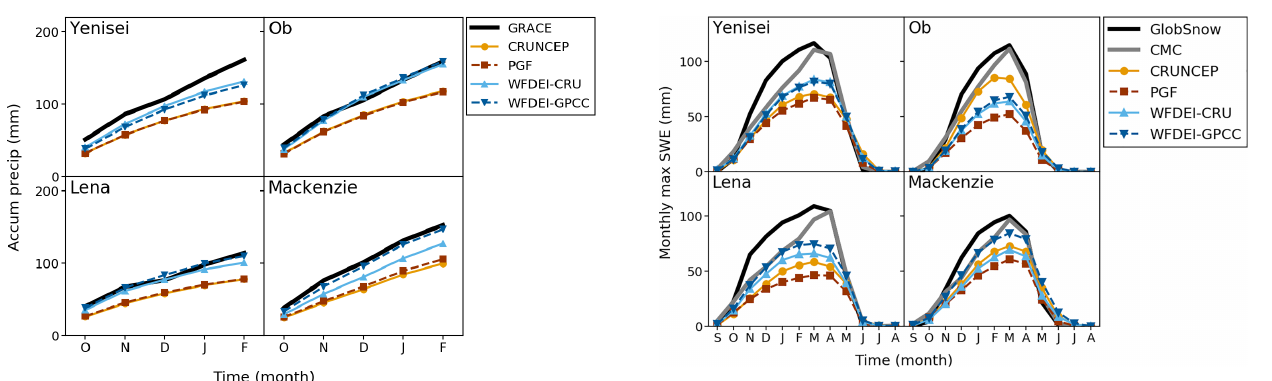
Figure 2. Mean monthly accumulated cold-season precipitation from October up to and including February, averaged over the com- mon overlap period, 2002–2010, as derived from GRACE TWS (Sect. 4) and from the driving data sets (Sect. 2.1).